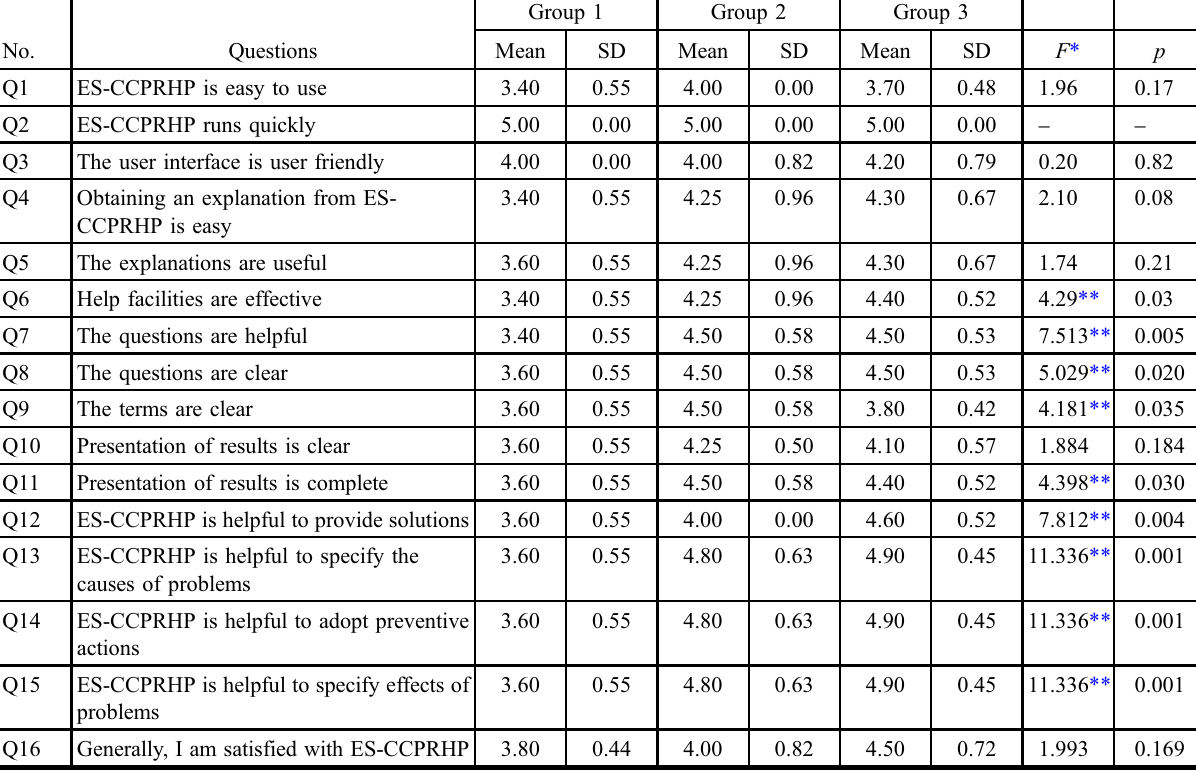
Table 5. Result of ES-CCPRHP evaluation statistically tested by ANOVA